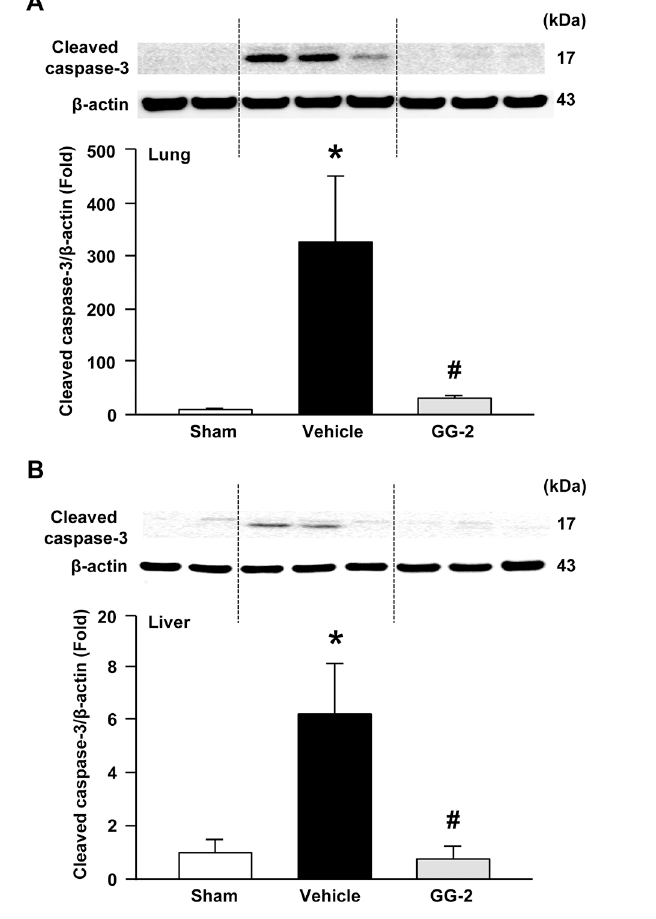
Figure 7. Effect of the combined treatment on caspase-3 activation in the organs of aged septic rats. Rats were sham operated or subjected to CLP with injection of vehicle (normal saline) or GG-2 (80 nmol/kg of ghrelin and 50 μ g/kg of GH) at 5 h after CLP. The tissues were harvested at 20 h after CLP for the protein extraction. Levels of cleaved caspase-3 in the (A) lung and (B) liver tissues were determined by Western blotting. Rep- resentative blots against cleaved caspase-3 and β -actin. Blots were scanned and quan- tified with densitometry. The levels of protein expression in sham group are designated 1 for comparison. Data are expressed as mean ± SE (n = 5–7 per group). * P < 0.05 versus sham and # P < 0.05 versus vehicle.